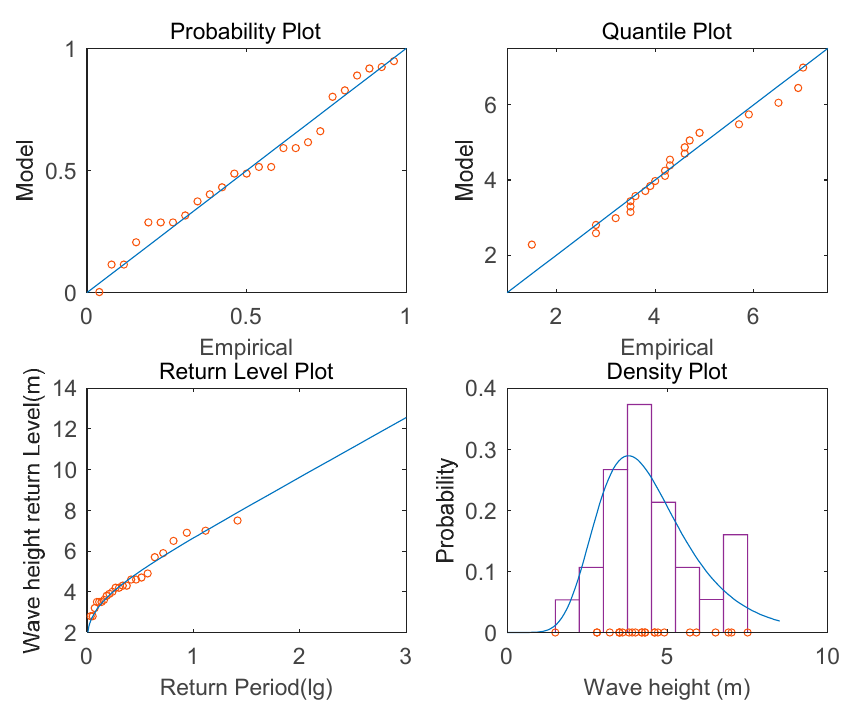
Figure 3. Inspection diagram of annual extreme wave height data of Gumbel distribution.